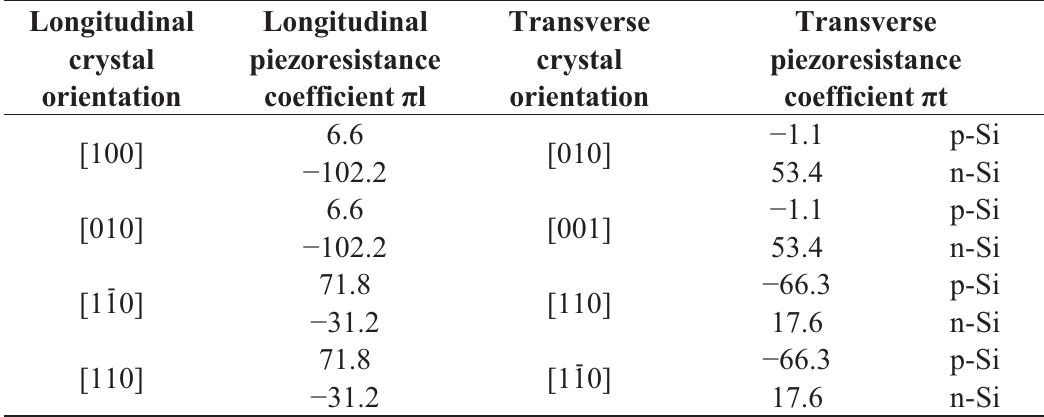
Table 1. The piezoresistance coefficient of p-Si and n-Si.